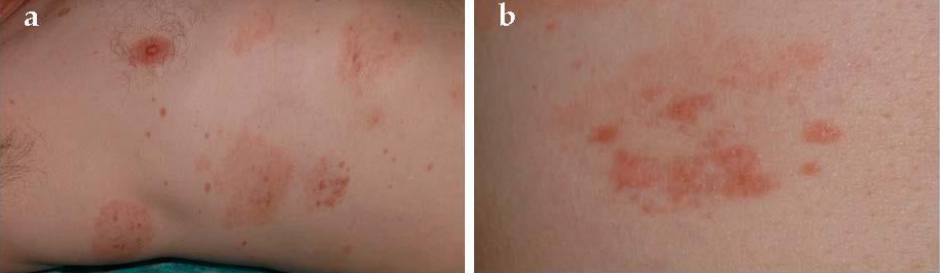
Figure 6. Eczematid-like purpura of Doucas and Kapetanakis. ( a , b ) Scaly petechial and purpuric macules and patches involving the abdomen.